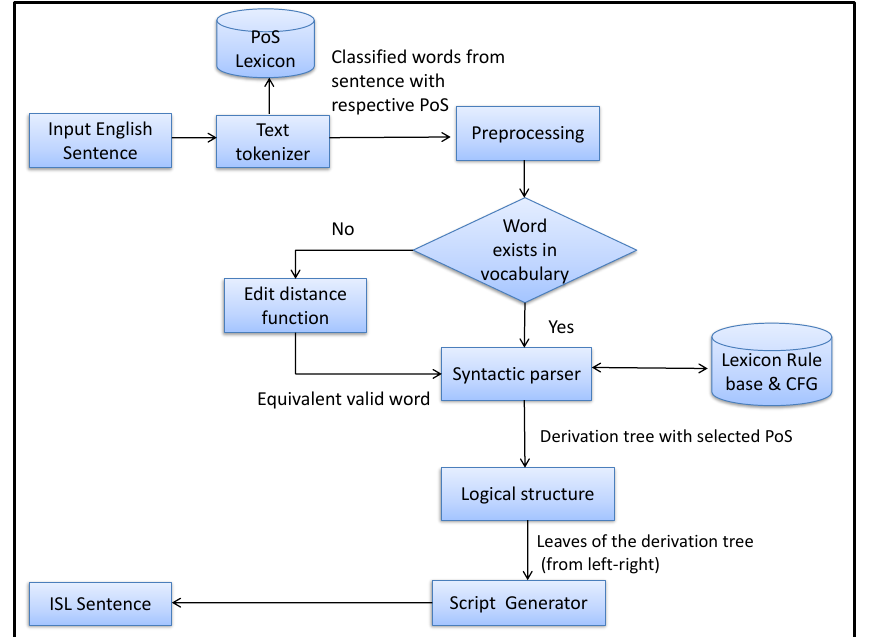
Figure 3. Model of ISL sentence generation from English sentence. PoS: Part-of-Speech; CFG: Context-Free Grammar.